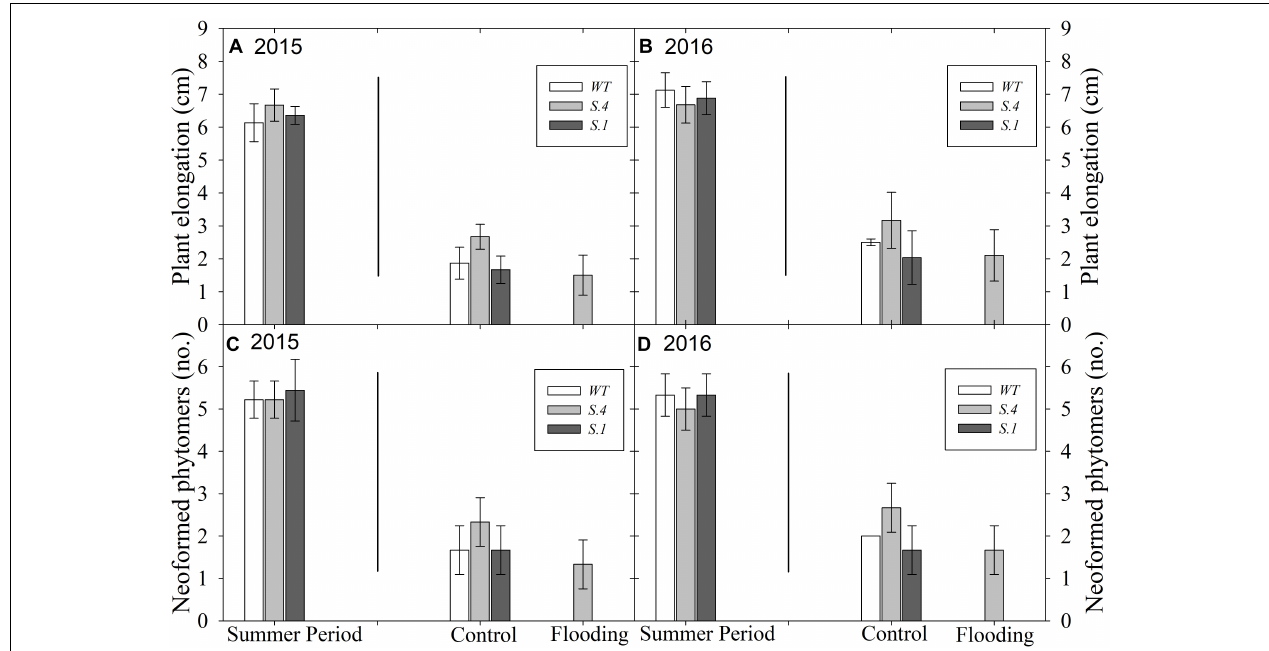
FIGURE 1 | Plant growth and development under Constant Photoperiod (CP) performed in 2 years consecutive tests. In (A,B) is shown the plant growth detected as stem elongation; in (C,D) is shown the development of new laterals buds (phytomers). Lines inside the graphics separate, on the left, the plant behavior under CP starting from 10th day of July until the beginning of flooding treatment, and on the right, the plant behavior under flooding treatment starting from the 10th day of September. All data were detected at the end of waterlogging treatment ( n = 5 biological replicate samples, ±